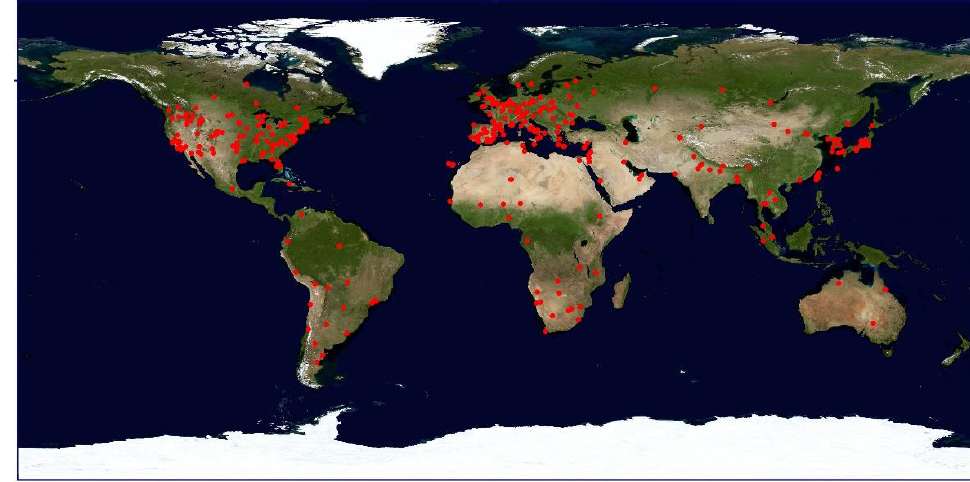
Figure 2. Spatial distribution of AERONET sites used in this study. Each point represents a site.